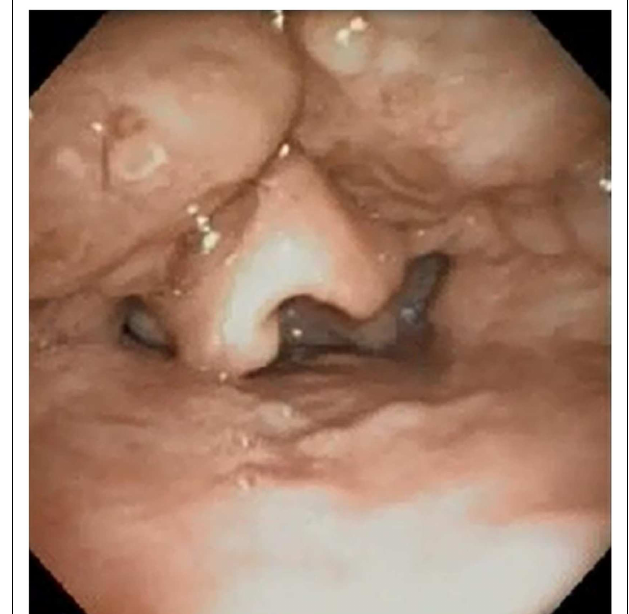
FIGURE 3 | Lingual tonsil hypertrophy visualized on sleep endoscopy